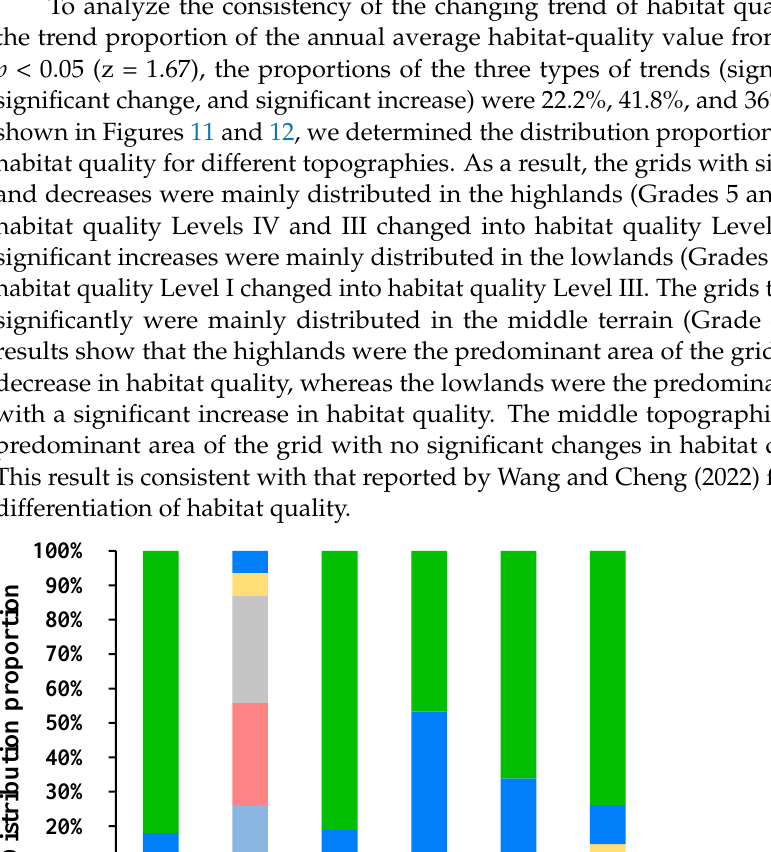
Figure 13. Predominant changes in habitat quality for different topographic positions. 4.2. Impact of Human Activities on Habitat Quality Human disturbances in habitat quality are mainly caused by construction, develop- ment, reclamation, and logging. Construction, development, and reclamation change the land-use type from woodland or shrub woodland to constructed land or cultivated land, resulting in changes to the ecosystem structure. A mutation point is observed before and after the disturbance [46]. The economic development of the highlands in the upper reaches of the Minjiang River (terrain of Grades 5 and 6) is relatively backward, and the structures of agriculture, animal husbandry, and people’s livelihood are relatively simple. The livelihoods of some of the poorer people are excessively dependent on woodlands and grasslands, which show a high development intensity that exceeds their carrying capacity, causing great damage to the natural resources and environment [35]. In high-terrain areas, poor farmers lack livelihood assets, resulting in their inability to develop alternative resources, so they can only rely on free energy sources (e.g., turf and trees), which aggravates soil erosion and forest destruction. The energy consumption behavior, which is mainly based on en- ergy needed for living, has become the most basic factor behind the environmental deg- radation in ecologically fragile areas [ 47 ]